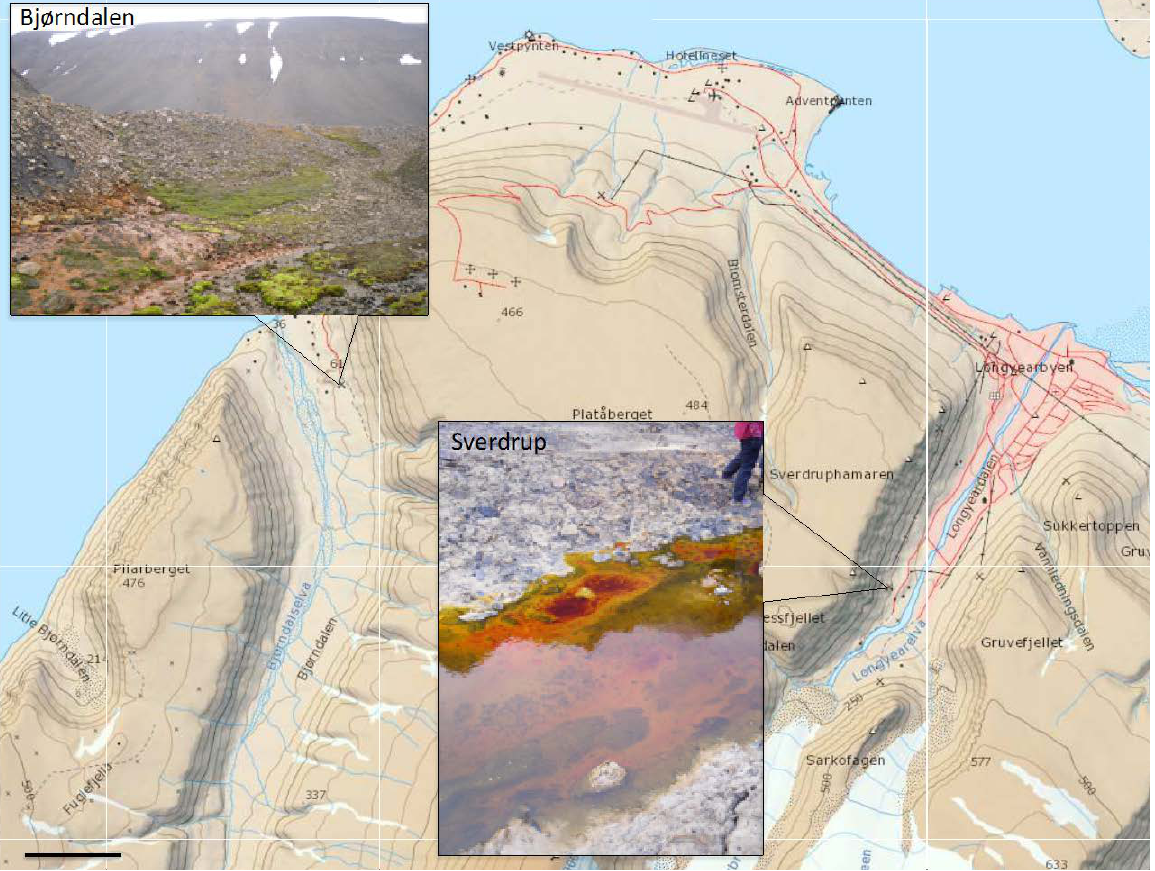
Figure 1. Area map that shows the study sites near Longyearbyen in Svalbard. Scale bar 1 km. Contour interval 50 m. The map was obtained from the Norwegian Polar Institute and it is licensed under the Creative Commons Attribution 4.0 International (CC BY 4.0) license